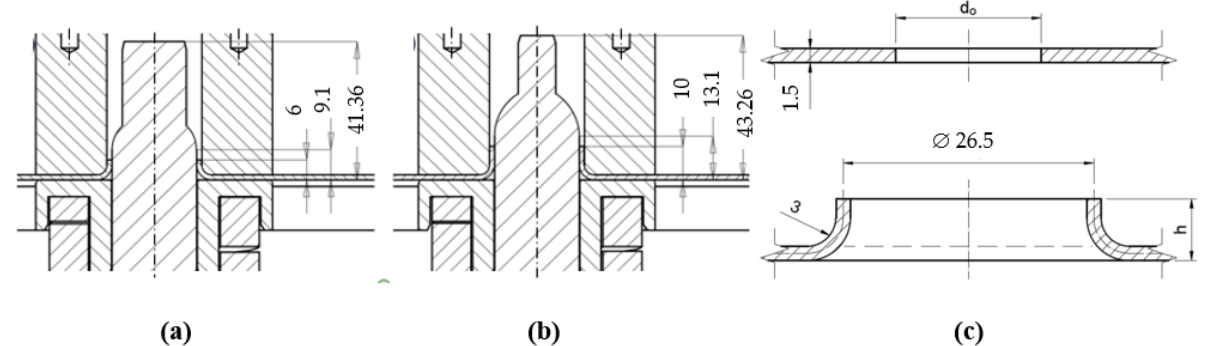
Figure 6. Cross-sections of the tools used for the circumferential stretching of the holes: a flange forming tool h 1 = 6 × 10 − 3 (m) high ( a ), a flange forming tool h 2 = 10 − 2 (m) high ( b ), and theoretical geometrical parameters of a shaped flange ( c ).